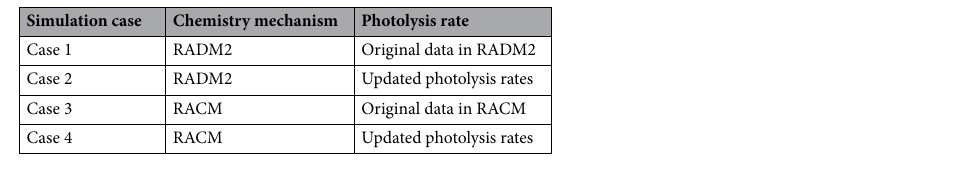
Table 4. Four simulation